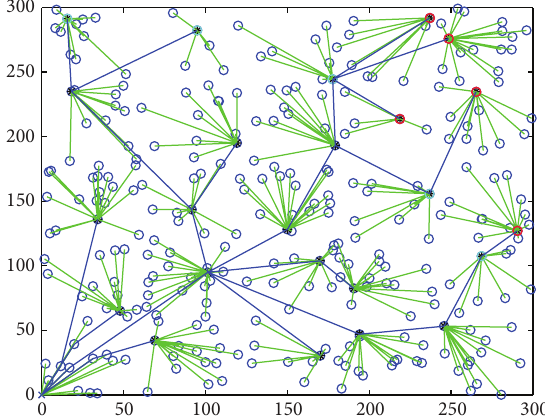
Figure 5: The topology for